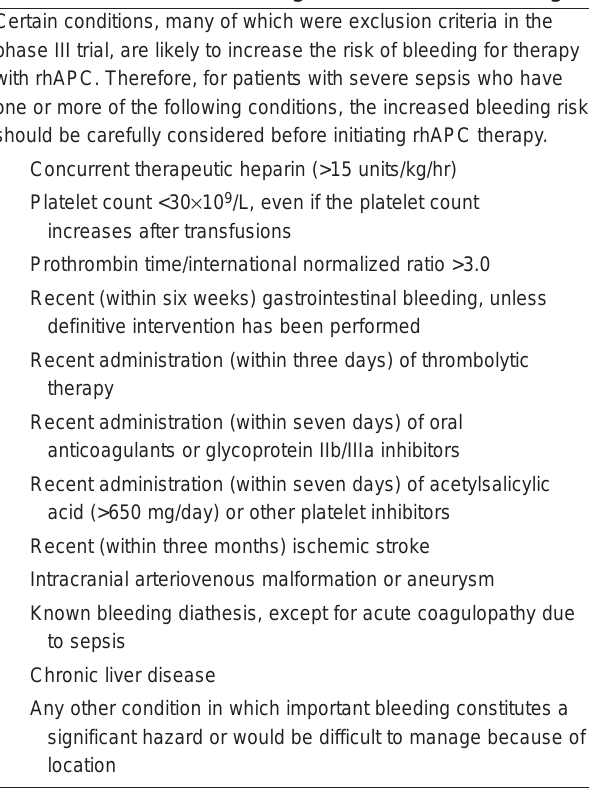
TABLE 8 Recombinant human activated protein C (rhAPC): United States Food and Drug Administration